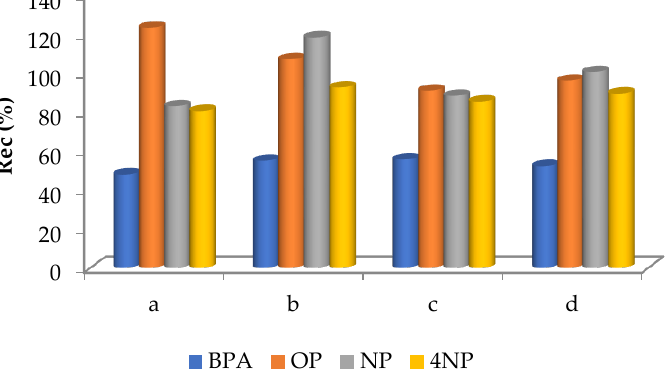
Figure 2. Influence of the different salts’ combination of the dSPE cleanup step on the analytes recovery from a milk sample spiked at 100 ng g − 1 : ( a ) MgSO4/PSA; ( b ) MgSO4/PSA/C18; ( c ) MgSO4/PSA/GCB and ( d ) MgSO4/PSA/C18/GCB.